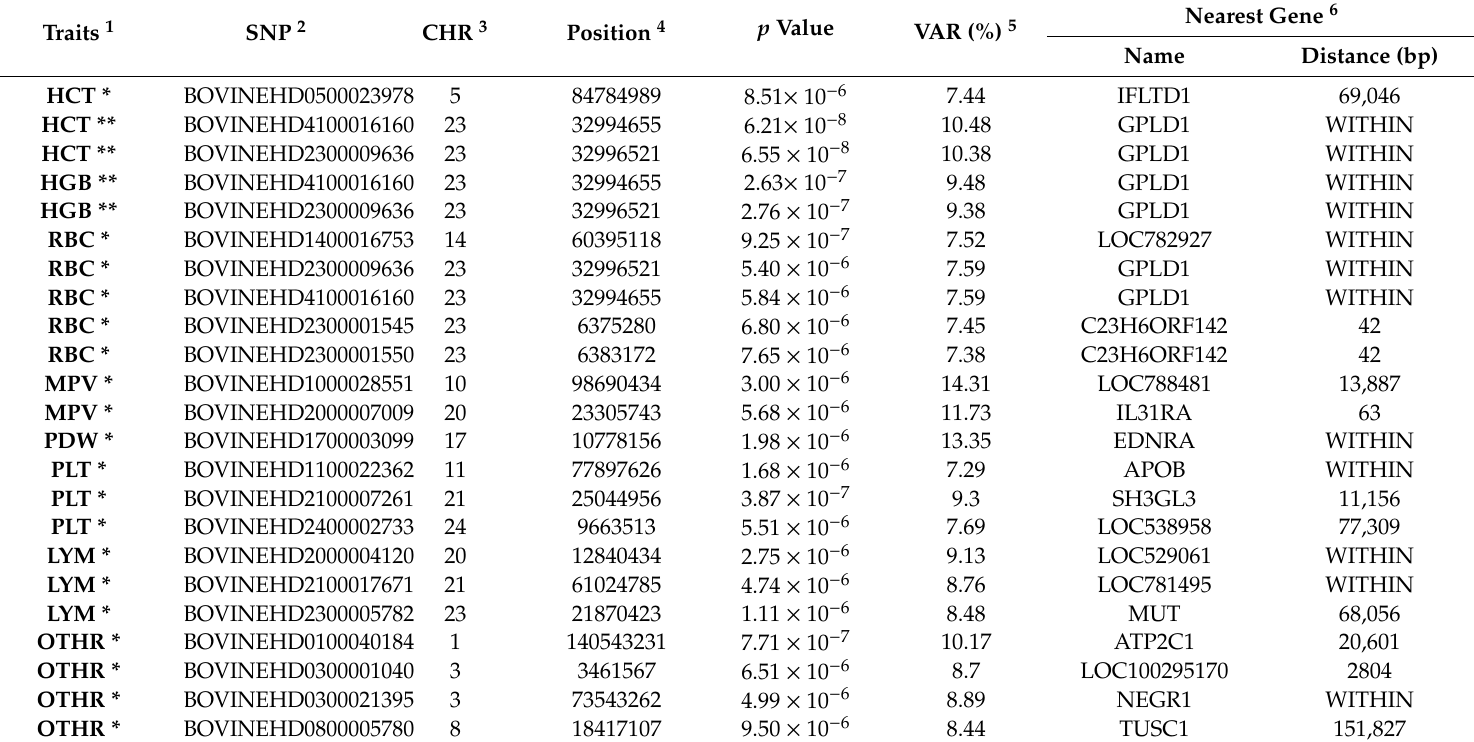
Table 2. Associated SNPs and nearby candidate genes for hematological